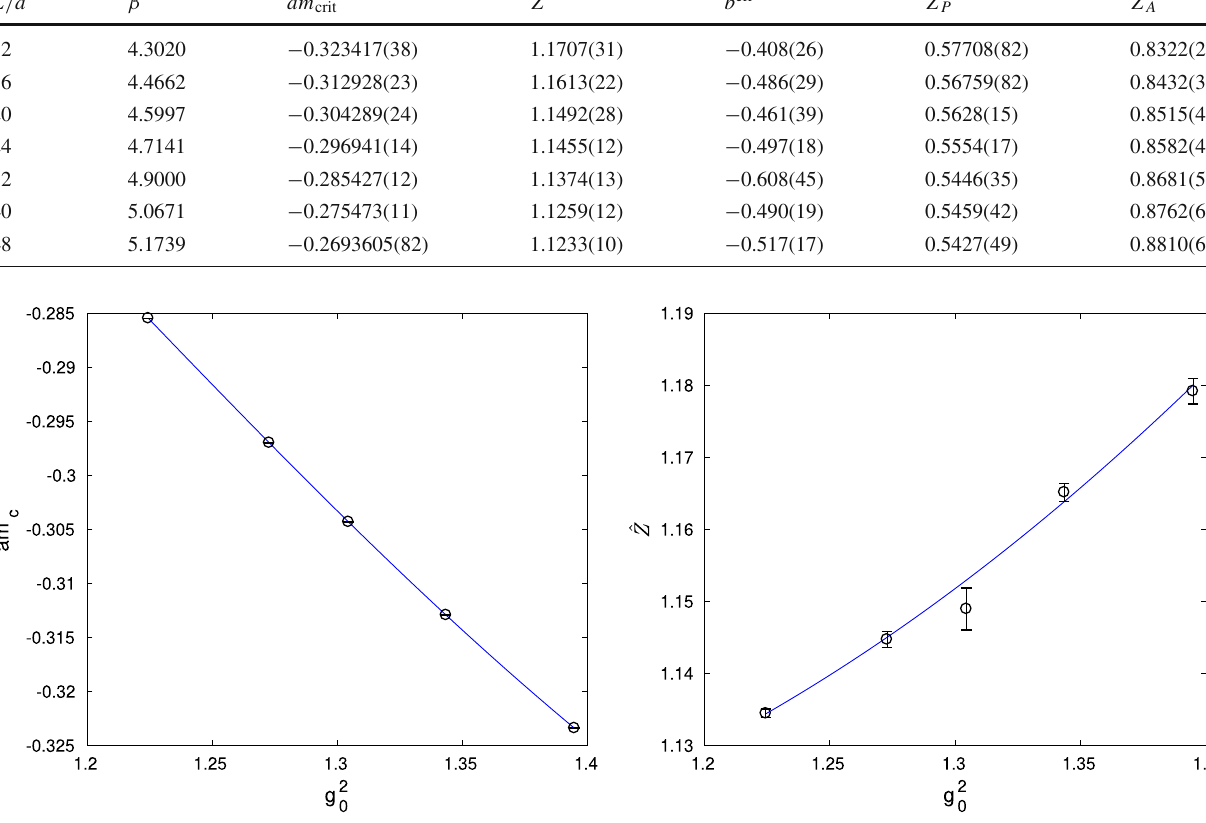
Fig. 8 Critical mass and ˆ Z as a function of g 2